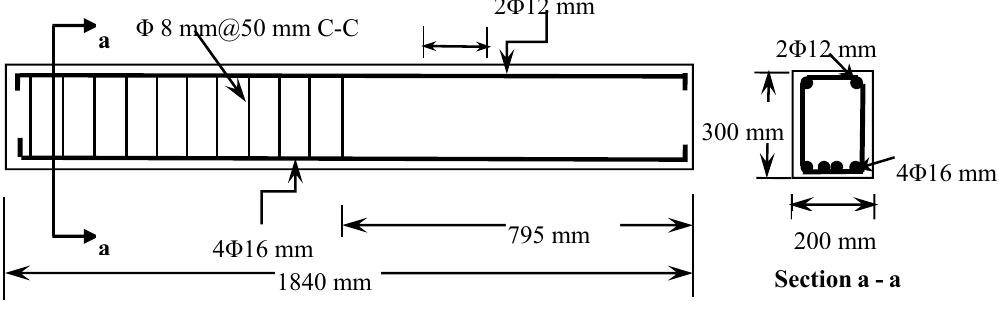
Figure 1. Longitudinal and cross-section details of the beam specimen.